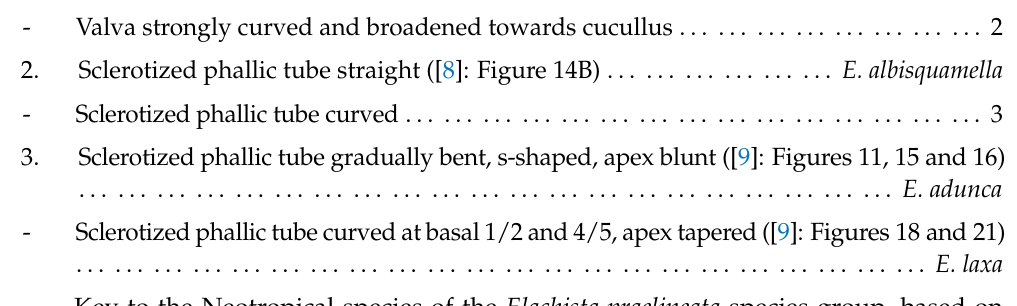
Sclerotized phallic tube curved at basal 1/2 and 4/5, apex tapered ([9]: Figures 18 and